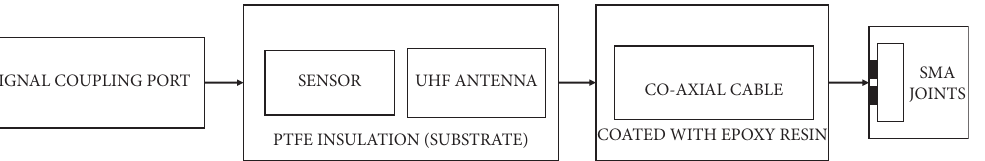
Figure 6: Structure of PTFE sensing